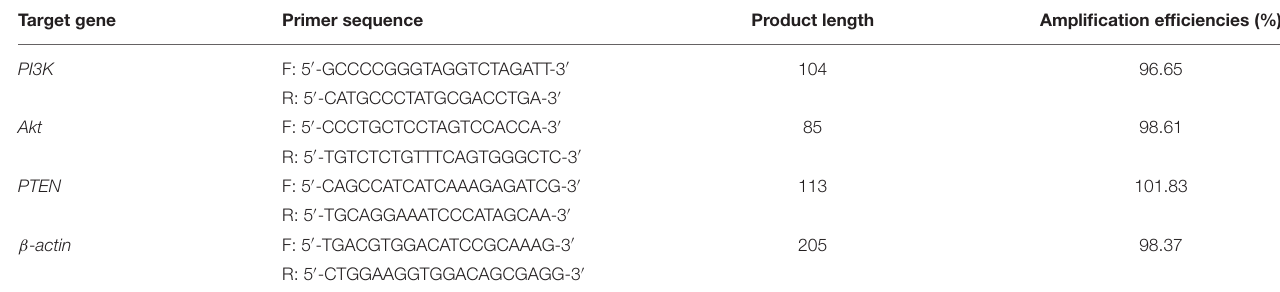
TABLE 1 | Primers used for the RT-qPCR analysis. Target gene